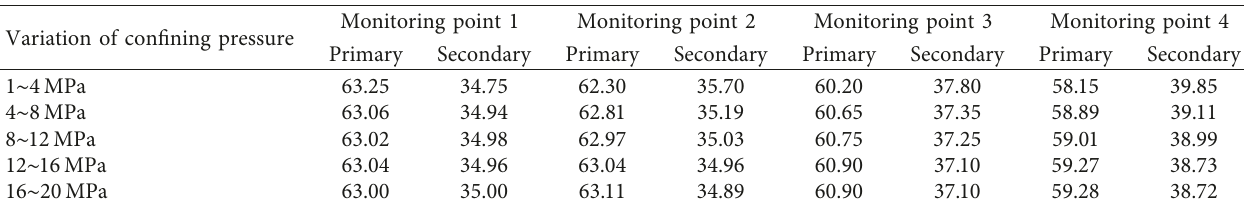
Figure 8: Stress waves’ propagation in rock mass with the fracture. (a) Stress propagation within 30 μ s. (b) Stress propagation within 120 μ s. (c) Stress propagation within 400 μ s. (d) Stress propagation within 660 μ s. Table 3: Proportions of primary and secondary frequency bands in the increase amplitude of total energy in frequency bands at monitoring points 1 ∼ 4 (%).